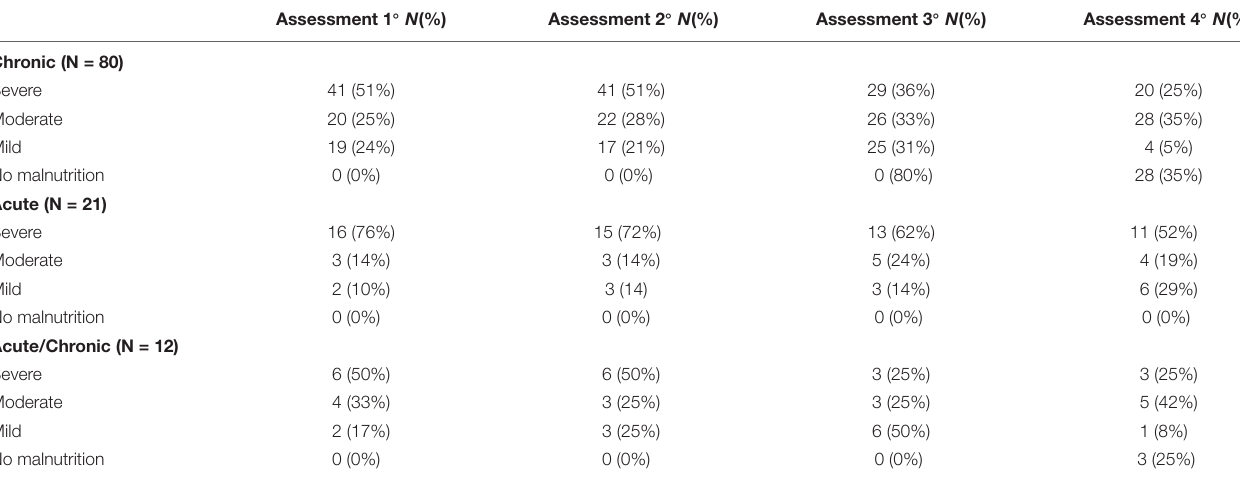
TABLE 2 | umber and percentages of children with severe, moderate, mild, and no malnutrition, at all four assessments. Assessment 1 ◦ N